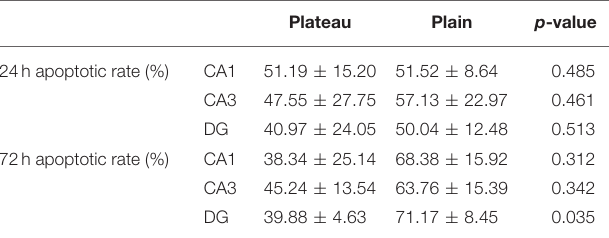
TABLE 3 | Apoptotic rates revealed by TUNEL staining in the plateau and plain groups at 24 and 72h after the last seizure. Plateau Plain p